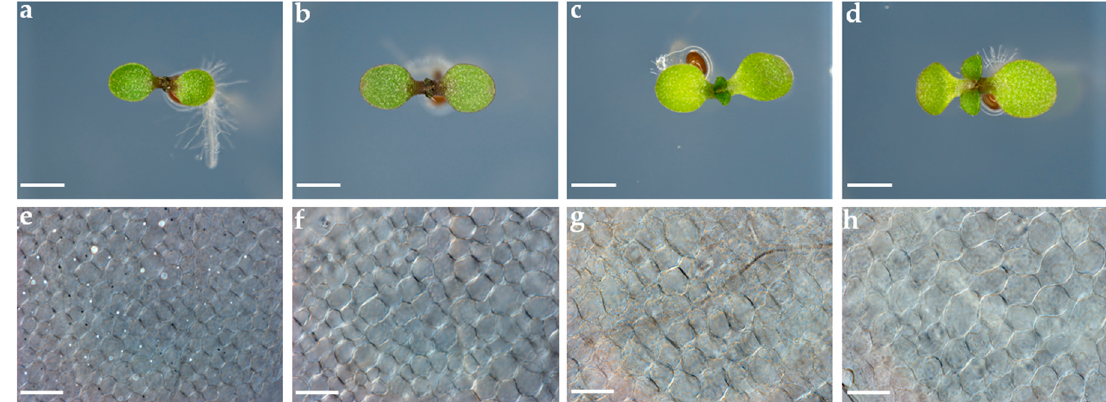
Figure 4. PAW treatment increases the Arabidopsis cotyledon dependent on the palisade cell size. ( a – d ) cotyledon size examined by a stereo microscope. ( e , f ) Palisade cells were examined from a cleared cotyledon sample under a differential interference contrast (DIC) microscope. ( a , e ) Deionized water (DW), ( b , f ) PAW5, ( c , g ) PAW19, ( d , h ) PAW40. ( a – d ) Bar = 1000 μ m. ( e – h ) Bar = 50 μ m . Table 3. Cotyledon size and palisade cell size and number of Arabidopsis grown in the DW and PAW treatment condition at 10 days after planting.